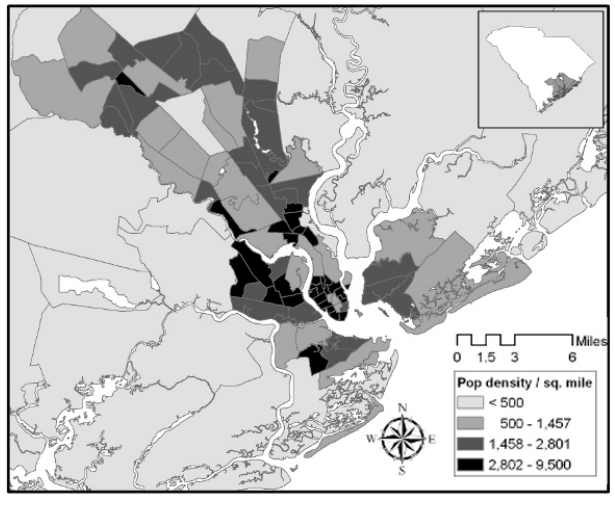
Fig. 2. Population density per square mile for census tracts in the Charleston-North Charleston metropolitan statistical area for the year 2000 (Source: U.S. Census Bureau